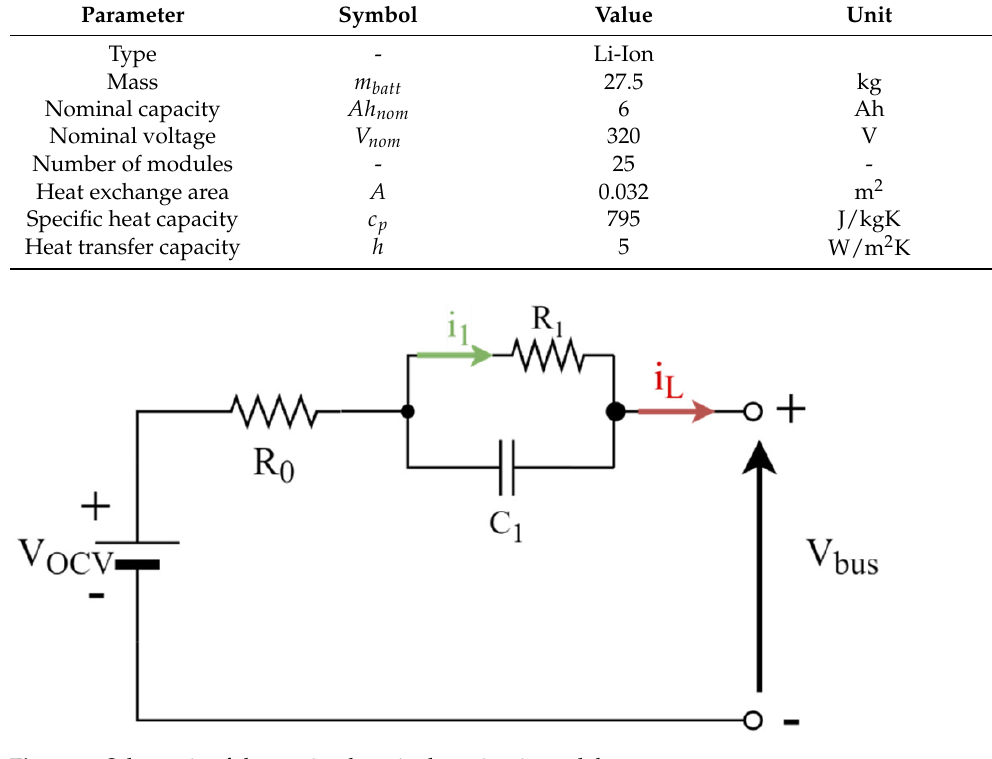
Figure 2. Schematic of the retained equivalent circuit model.